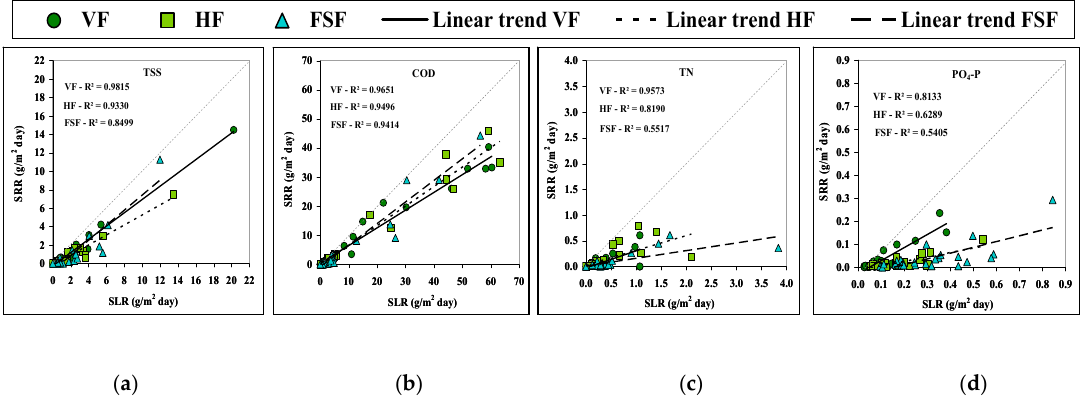
Figure 6. Relationship between surface loading rate (SLR) and surface removal rate (SRR) for Total Suspended Solids (TSS) ( a ), Chemical Oxygen Demand (COD) ( b ), Total Nitrogen (TN) ( c ) and PO 4 -P ( d ) in each CW unit.